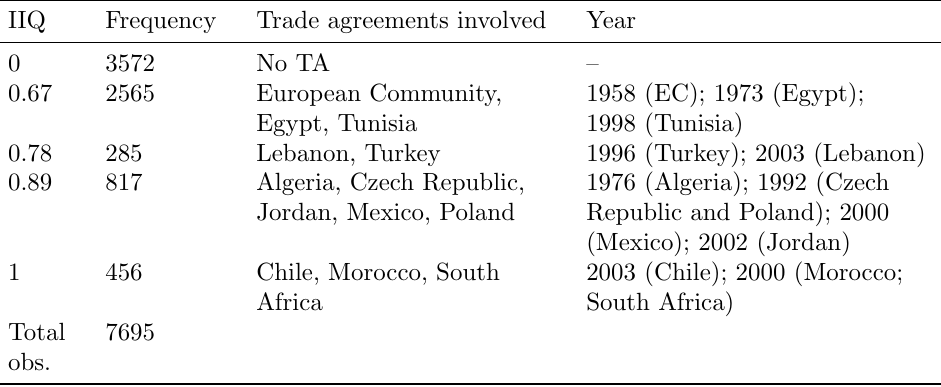
Table B.3: Descriptive statistics of the variable “TA institutional